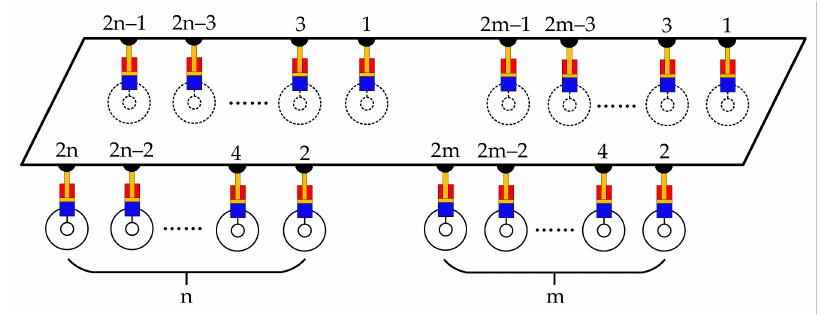
Figure 2. Multi-axle vehicle.